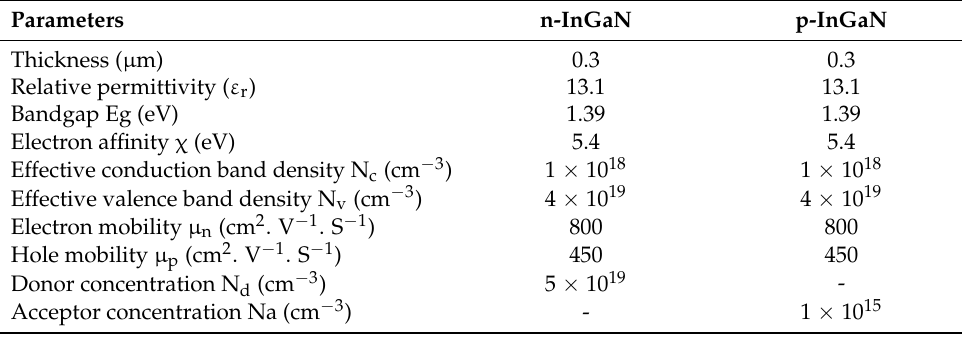
Table 1. Calibrated InGaN structure of material parameters.